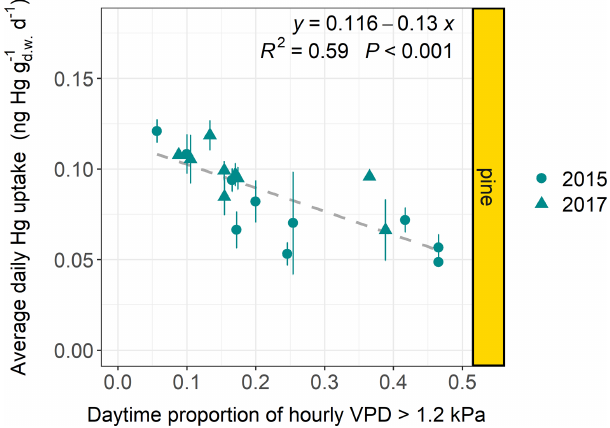
Figure 5. Average daily Hg uptake rates (ngHgg − 1 d − 1 ) of d.w. current-season pine needles from multiple forest plots ( n plots = 19) versus the proportion of daytime hours (06:00–18:00LT) within an average day of the respective sample life periods during which the hourly daytime water vapor pressure deficit (VPD) exceeded a threshold value of 1.2kPa. Data points originate from both sampling years 2015 and 2017. All forest plots are located in Central Europe (latitude 46–54 ◦ ), for which ambient air Hg(0) concentrations are relatively constant (see Table S2 and Fig. S6 in the Supplement). Error bars denote ± 1 standard deviation of daily needle Hg uptake rates between multiple samples at each forest